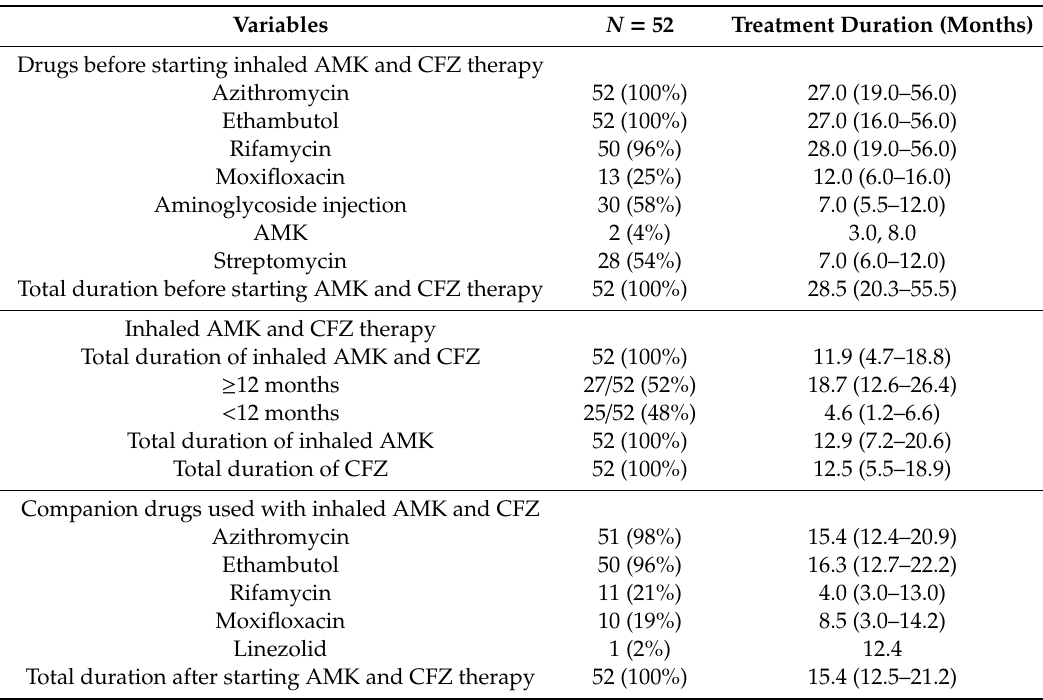
Table 2. Antibiotic treatment